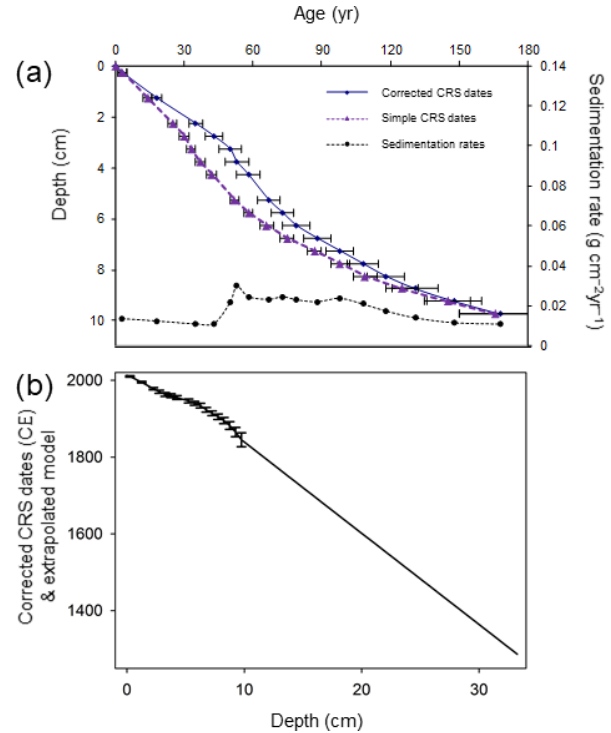
Figure 6. (a) Age–depth models and sedimentation rates using cor- rected CRS model for the Disko 2 K1 core. The simple CRS (con- stant rate of supply) model derived from 210 Pb dating only is in- dicated by purple triangles. The corrected CRS (constant rare of supply) model is derived from a 210 Pb base, with manual splice corrections based on the 137 Cs 1963 peak indicated by blue circles. (b) Extrapolated model for Disko 2 K1 short core with linear ex- trapolation of dates between 1940 and 1845CE used to extend the chronology to the base of the core. Error bars indicate measured 210 Pb samples to 1 σ standard